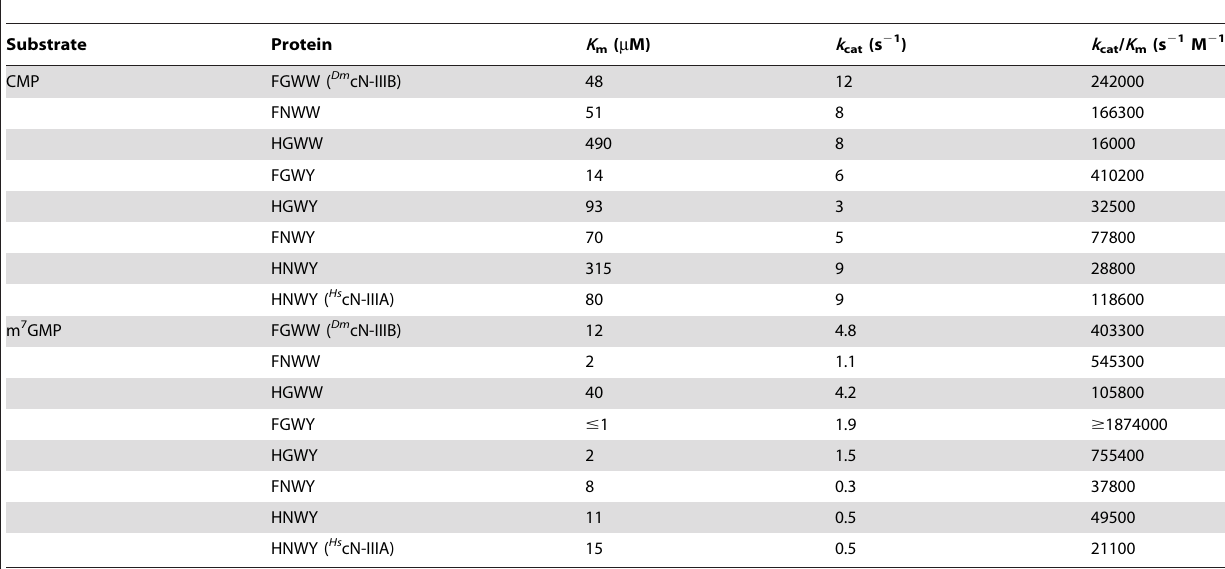
Table 3. Kinetic properties of the cytosolic 5 9 -nucleotidases IIIA, IIIB and variants of Dm cN-IIIB.